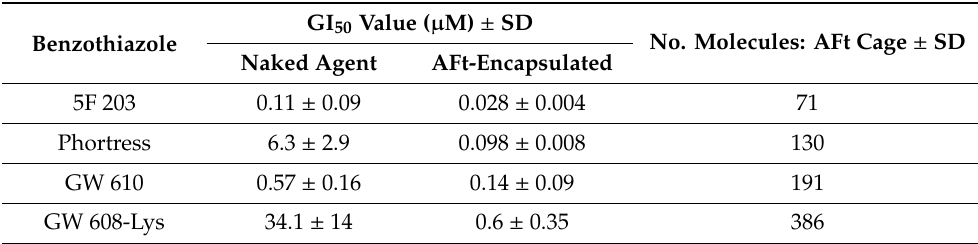
Table 2. A tabulated summary of GI 50 values following treatment of TK10 renal carcinoma cells with naked- and AFt-encapsulated antitumor benzothiazoles. MTT assays were conducted following 72 h exposure of cells to test agent. n = 3 per trial; ≥ 3 independent trials. The mean number of benzothiazole molecules encapsulated per AFt cage is also depicted.